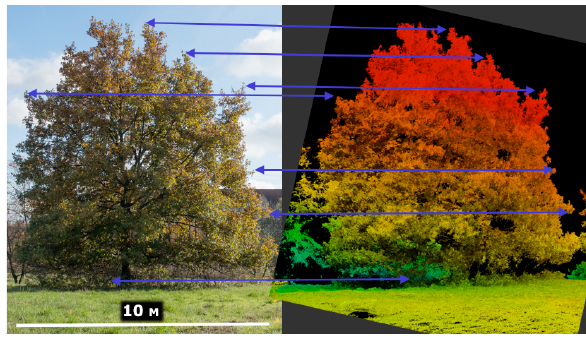
Figure 3. Tree crown structure point cloud (right) in Leaf-On status compared with a horizontal DSLR photograph made from the same perspective